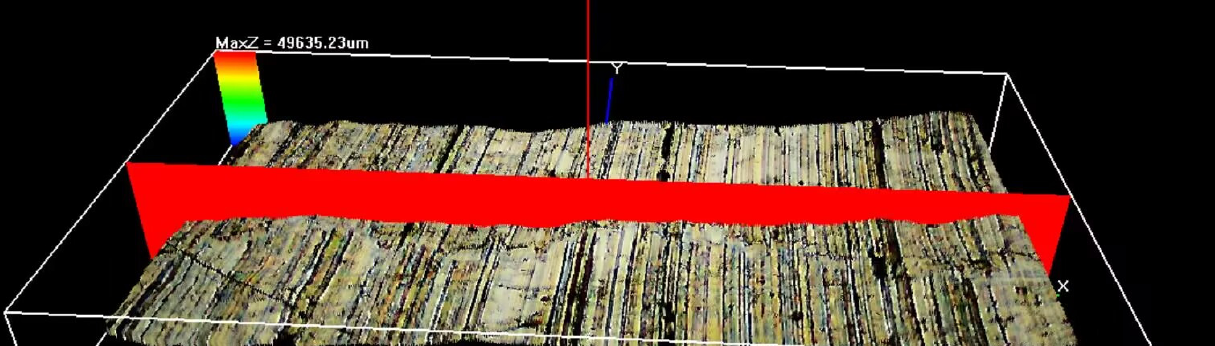
Figure 20. Workpiece surface topography machined by BEM.